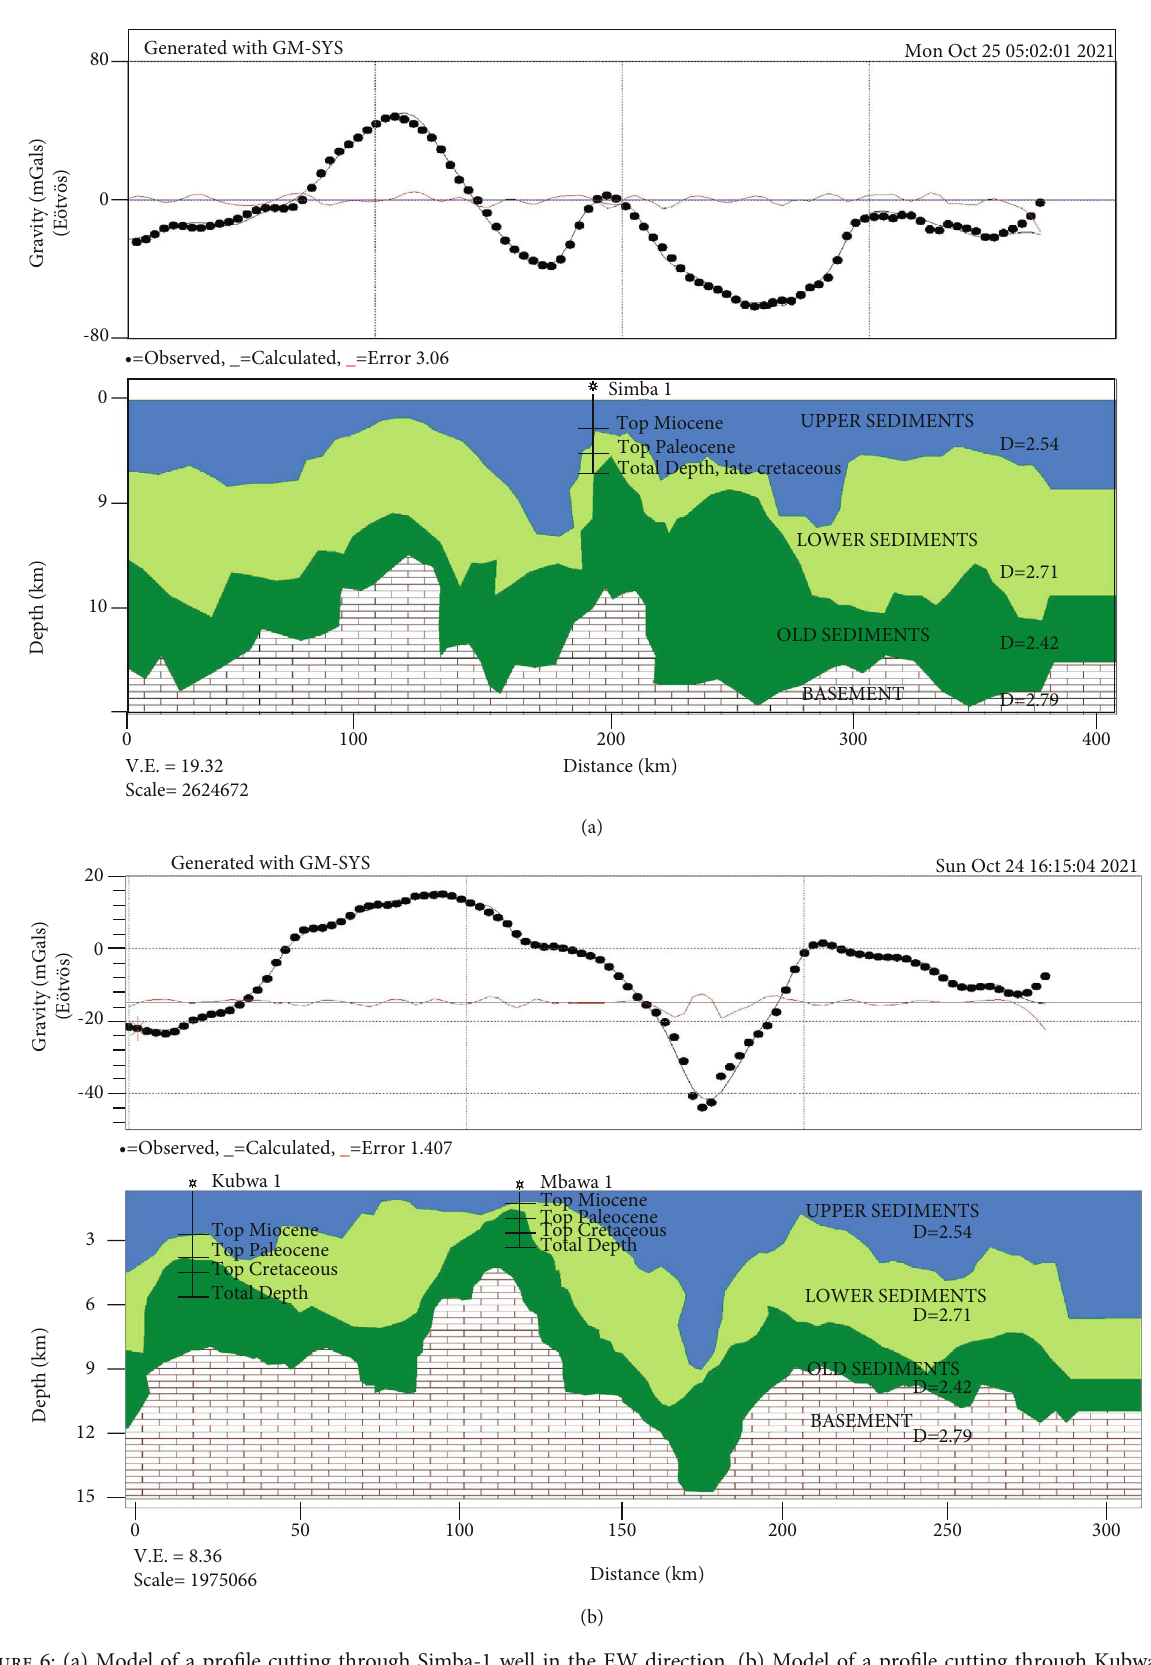
Figure 6: (a) Model of a pro fi le cutting through Simba-1 well in the EW direction. (b) Model of a pro fi le cutting through Kubwa-1 and